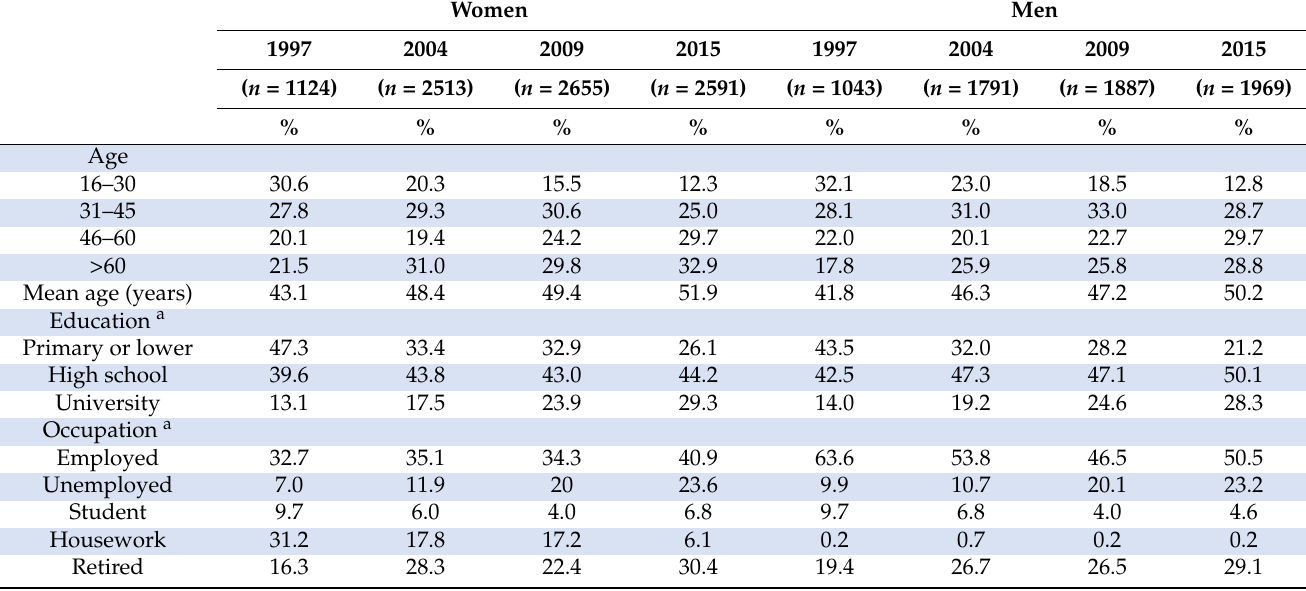
Table 1. Characteristics of the participants. Canary Health Survey (1997, 2004, 2009, and